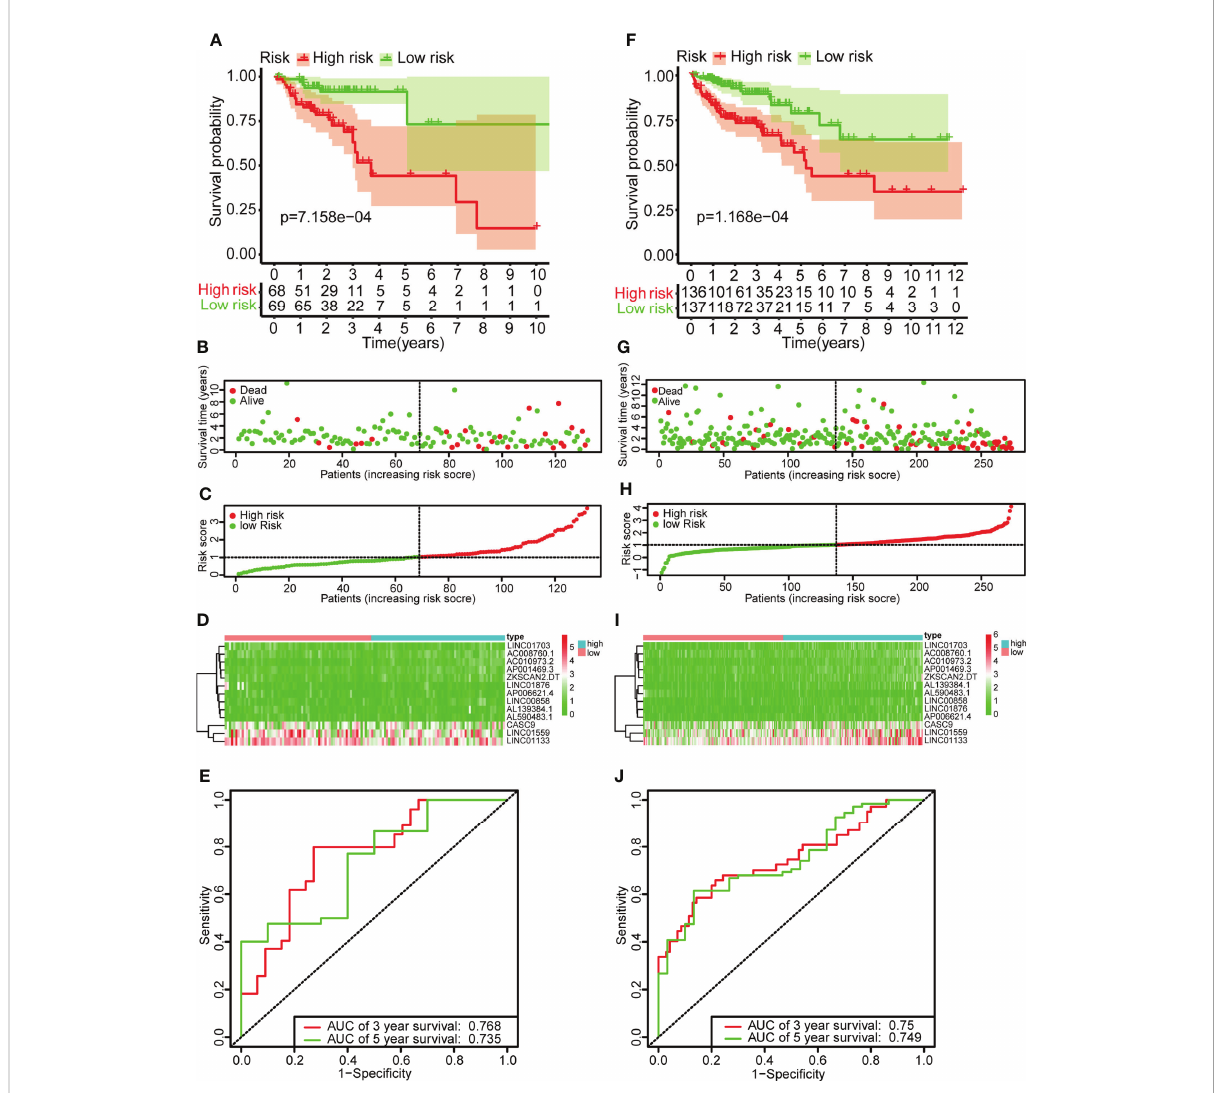
FIGURE 3 Construction of the risk scoring model. (A, F) Kaplan-survival Meier ’ s study of colon cancer patients in the training set and validation set indicated that the prognosis of the high-risk group was considerably poorer, while the low-risk group was better. (B, G) The survival rate and survival status of colon cancer patients in the training set and validation set. (C, H) The distribution of risk scores of 13 lncRNAs for colon cancer patients in the training and validation set. (D, I) Heat maps of 13 lncRNAs in the low-risk and high-risk group in the training set and validation set. (E, J) ROC curve analysis of colon cancer patients in the training set and validation set. The AUC values of the 3-year and 5-year survival rates of the training set were 0.768 and 0.735, respectively. The AUC values of the 3-year and 5-year survival rates of the validation set were 0.768 and 0.735,